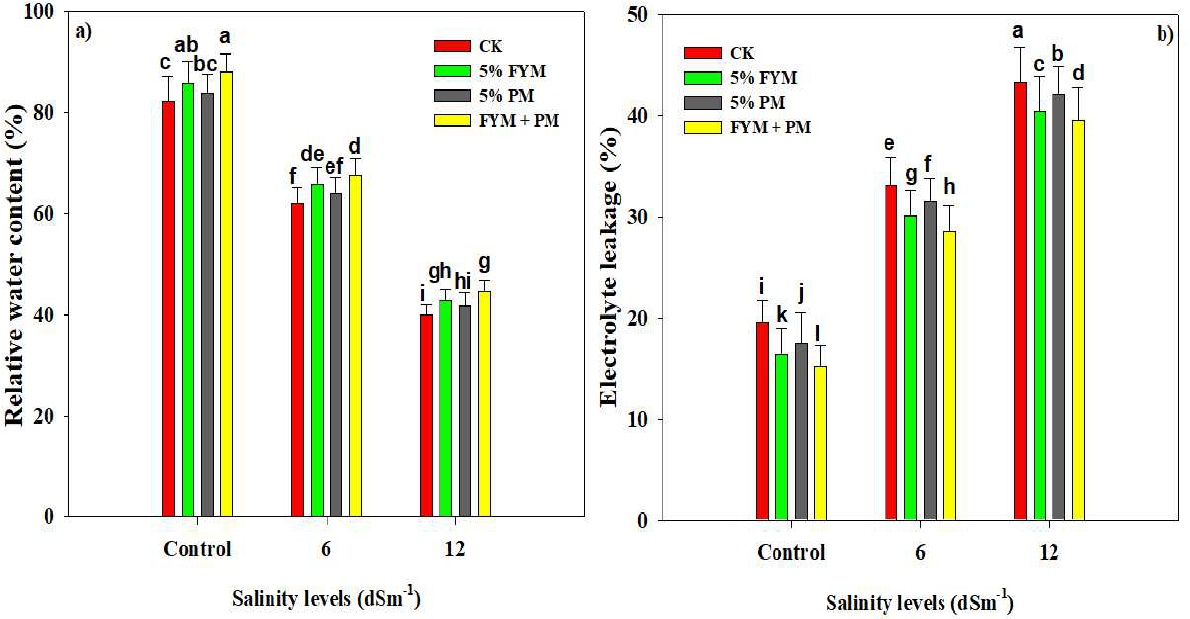
Figure 1. Effect of different organic amendments on relative water contents ( a ) and electrolyte leakage ( b ) under diverse leaves of salinity stress. The bars are means of four replicates with ±SE while diverse letters indicate significant differences at p < 0.05.